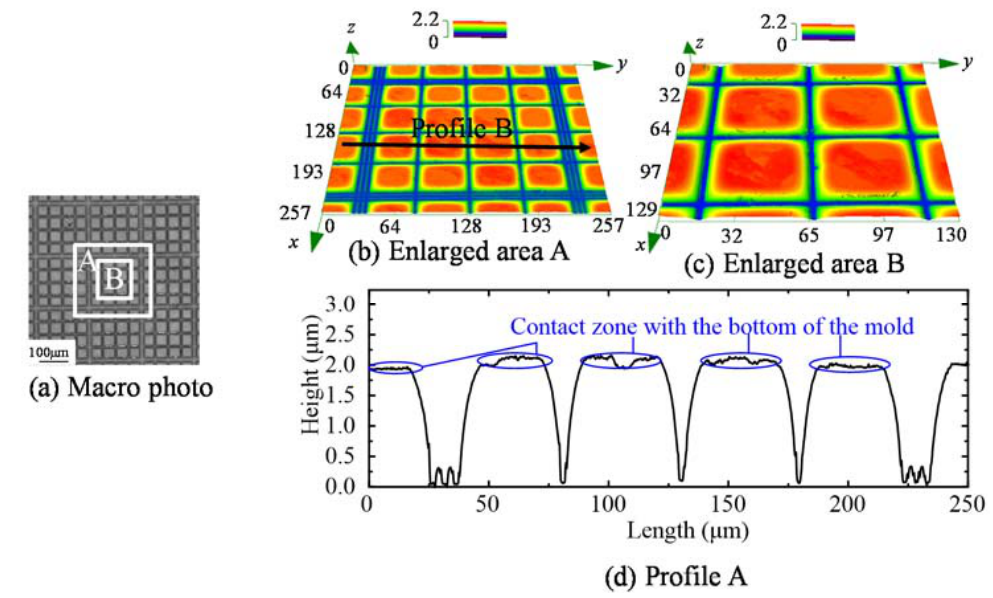
Figure 12. The microstructure of the molded cell counting chip (550 °C, 0.5 MPa). ( a ) Marco photo; ( b ) Enlarged area A; ( c ) Enlarged area B; ( d ) Profile A.